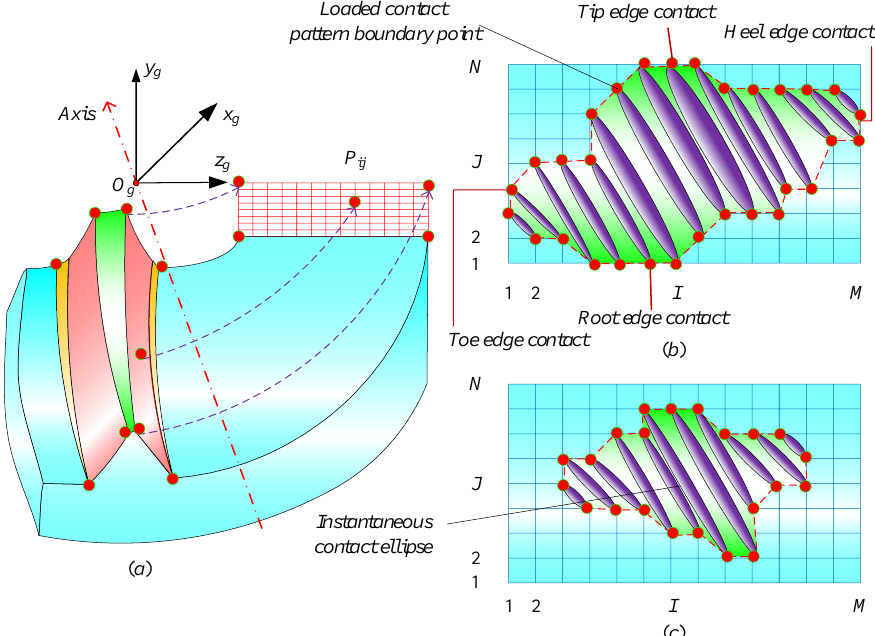
Figure 9. Tooth surface discretization and loaded contact pattern evaluation: ( a ) discretized points; ( b ) contact pattern with edge contact; ( c ) acceptable loaded contact pattern.